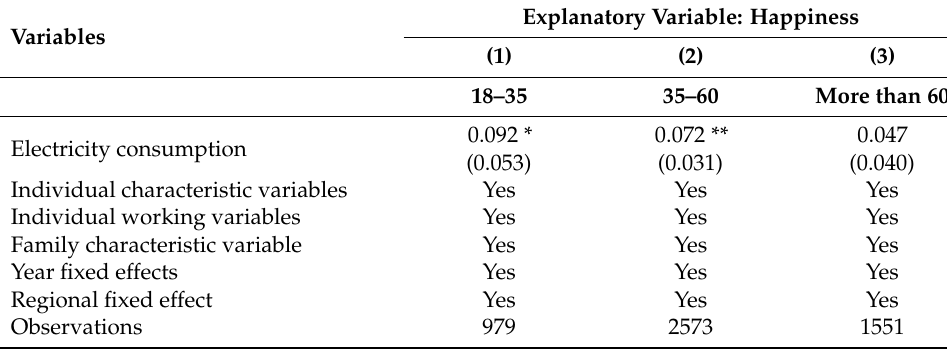
Table 7. Heterogeneity analysis from the perspectives of